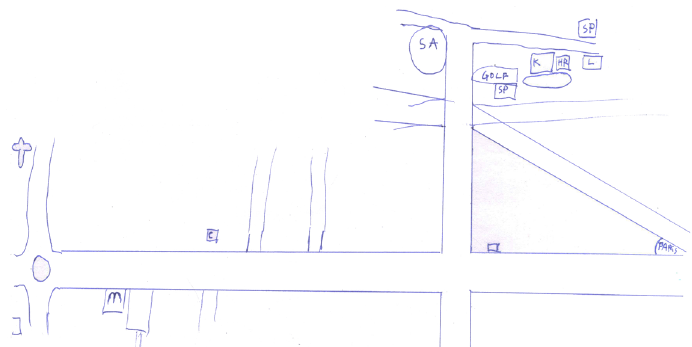
FIG. 3 Leo’s drawing highlights public facilities near his apartment: different kinds of stores, supermarkets, park, and